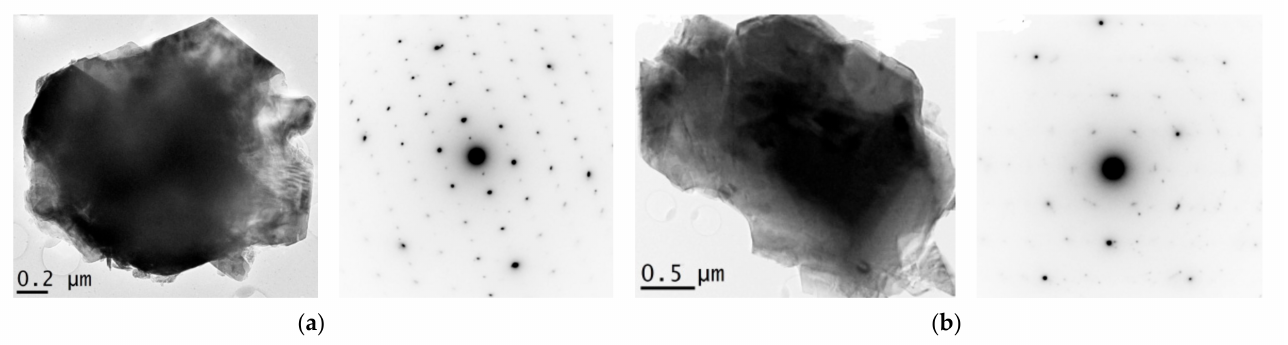
Figure 7. TEM images: gibbsite for biofilms type I ( a ), gibbsite by biomorphosis type II ( b ).